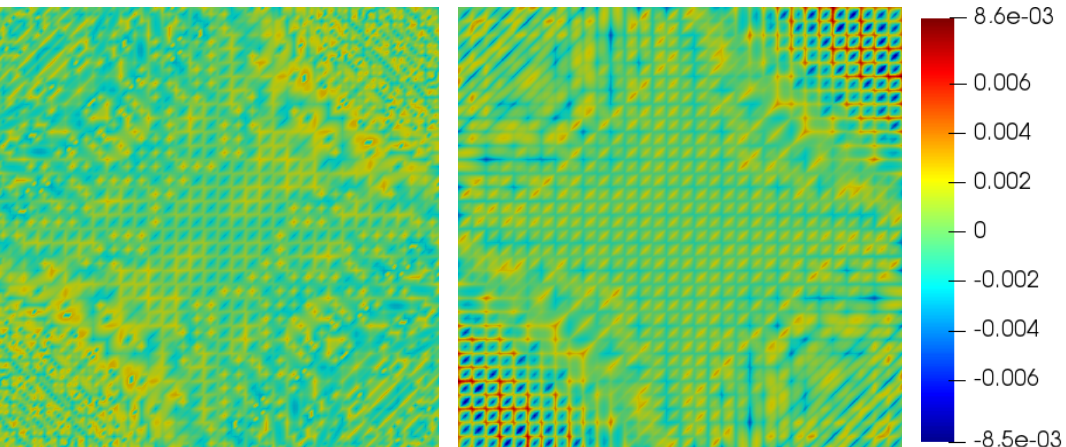
Figure 6. Comparison of quantization errors, i.e., error in the reconstructed solution yielding the same H − 1 error norm. Left: hierarchical basis. Right: wavelets. Using the H − 1 norm to measure the error allows larger pointwise absolute reconstruction errors compared to the L ∞ error metric, thus higher compression